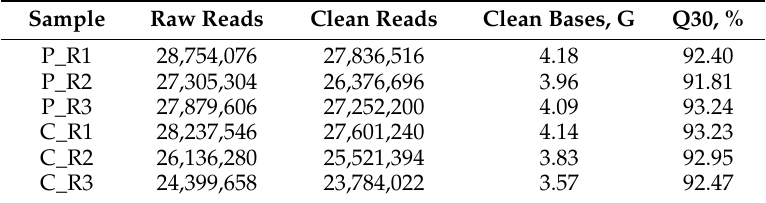
Table 6. The output quality data of the transcriptomic